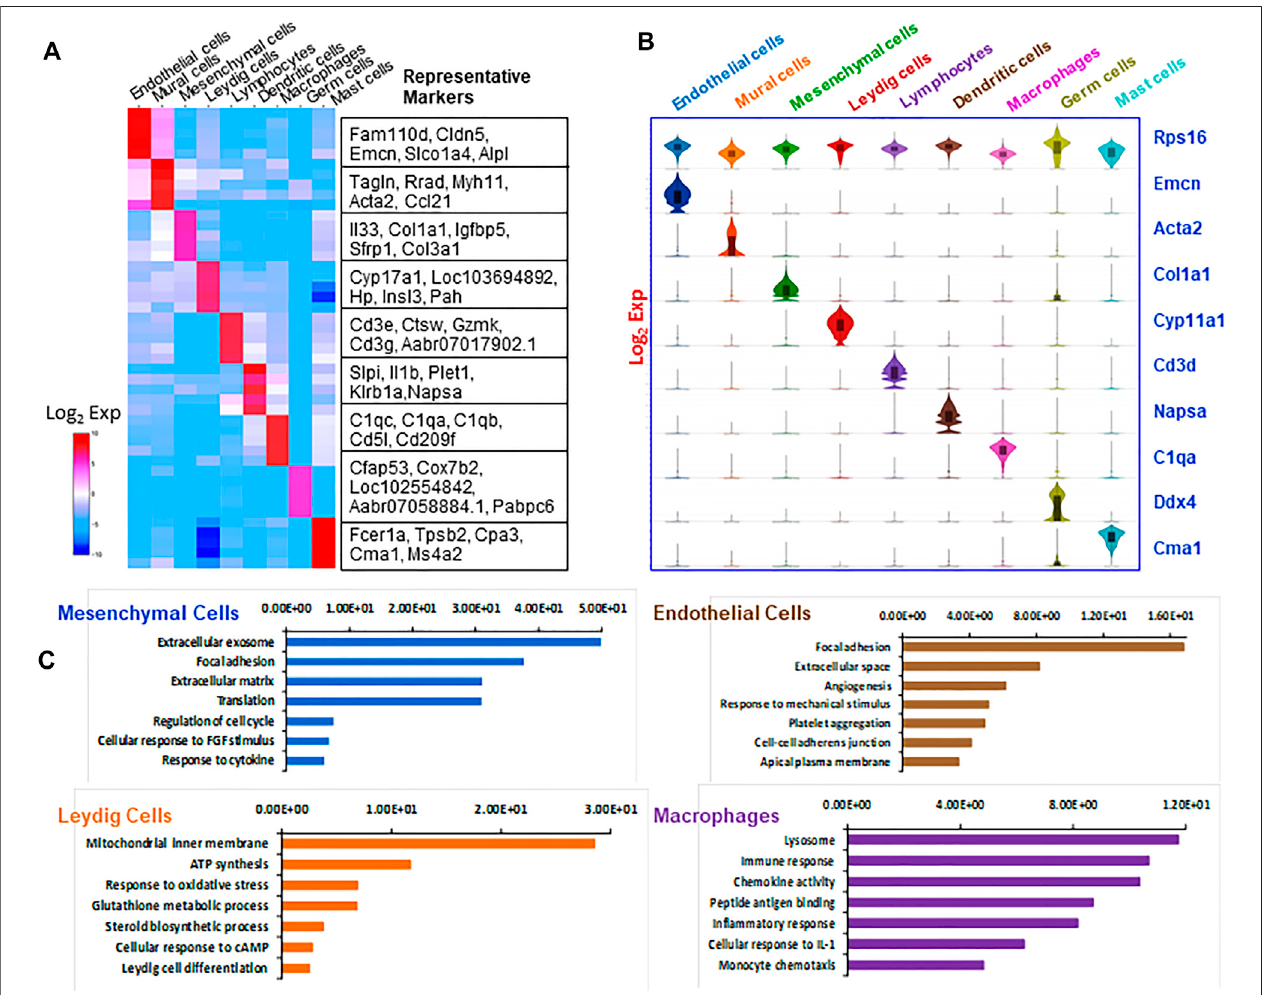
FIGURE2| Overviewofmarkersandattributesofthetesticularcelltypesidenti fi edbyscRNA-seq. (A) Heatmapshowsthetopmarkersassociatedwitheachofthe major cell types identi fi ed. (B) Violin-distributions of the marker genes exclusively expressed by each cell type identi fi ed. (C) The top seven gene ontology (GO) terms enriched for the four major cell